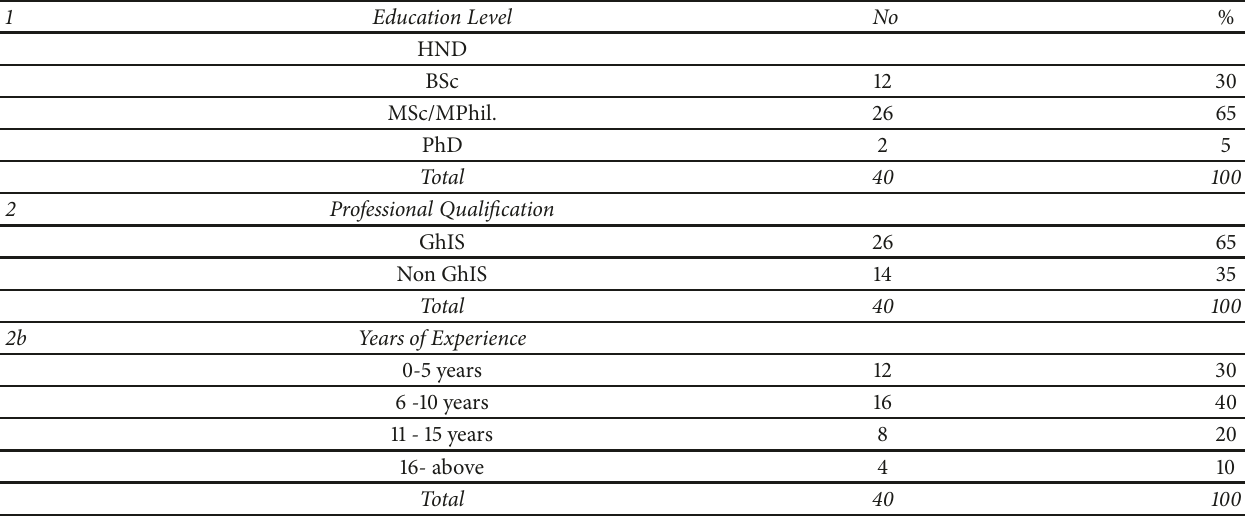
Table 1: Background information about respondents.